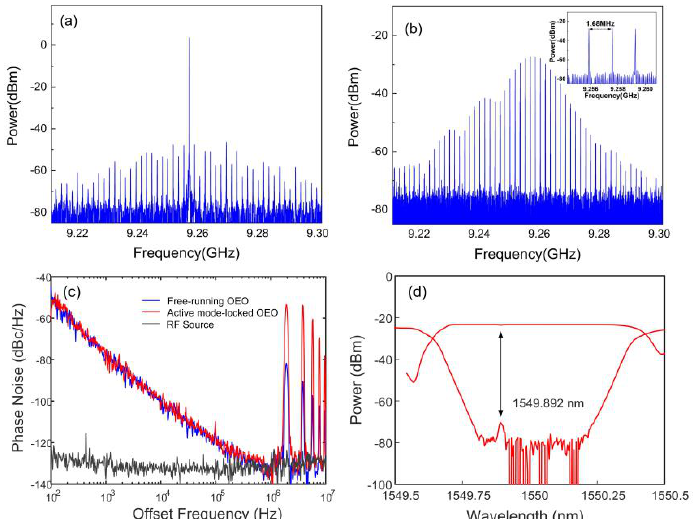
Figure 3. Measured frequency spectra of the microwave signals generated via the actively mode- locked OEO ( a ) without external injection and ( b ) with external injection; ( c ) phase noise of the inject RF signal and microwave signals generated by free-running OEO and actively mode-locked OEO; ( d ) reflection and transmission spectra of the PS-FBG.